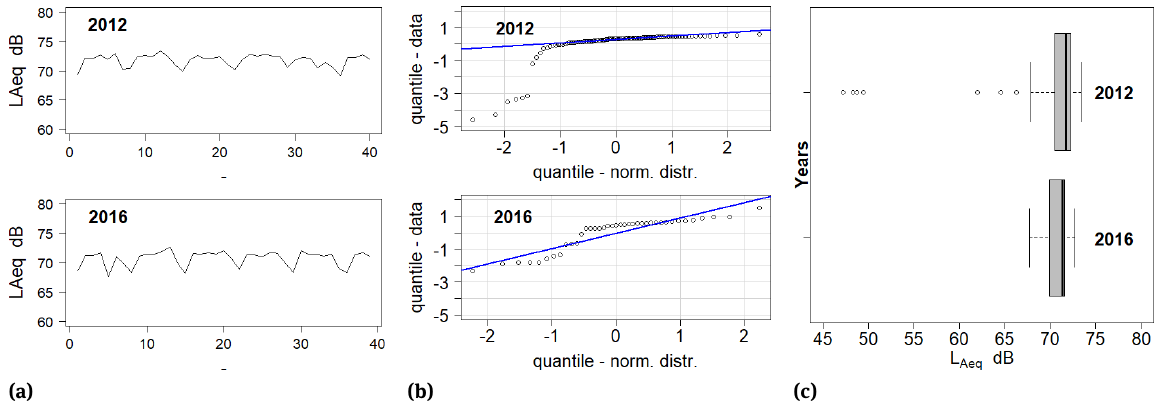
Figure 11: Equivalent sound level results from the monitoring station in Popiełuszki Av. recorded in 2012 and 2016; a) equivalent sound level variations, b) Q-Q plots, c) box plots